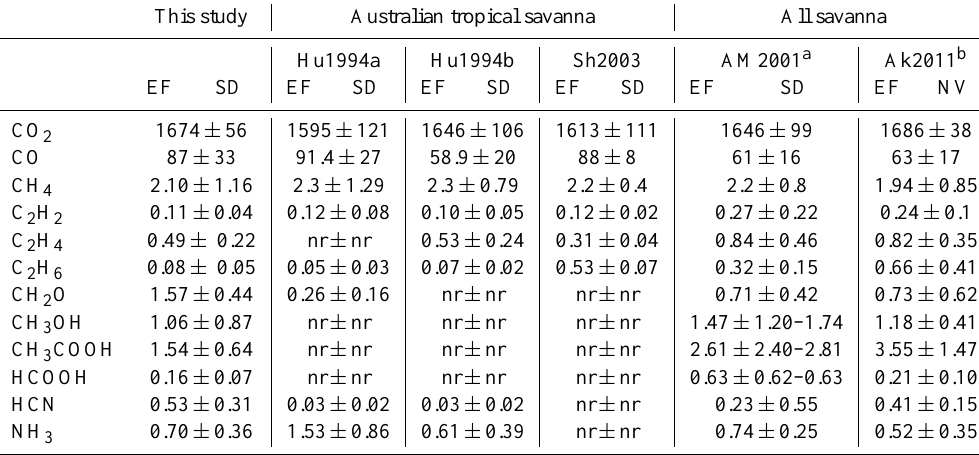
Table 5. Emission factors (gkg − 1 dry fuel burned) reported by this study and those for the same trace gases reported by previous Australian savanna studies (Hurst et al., 1994a, b; Shirai et al., 2003) and by Andreae and Merlet (2001) and Akagi et al. (2011) who estimate global savanna emission factors by amalgamating suite of emissions studies. For this study and the Australian savanna studies, the mean and standard deviation of the emission factor is calculated from individual fires. This study Australian tropical savanna All